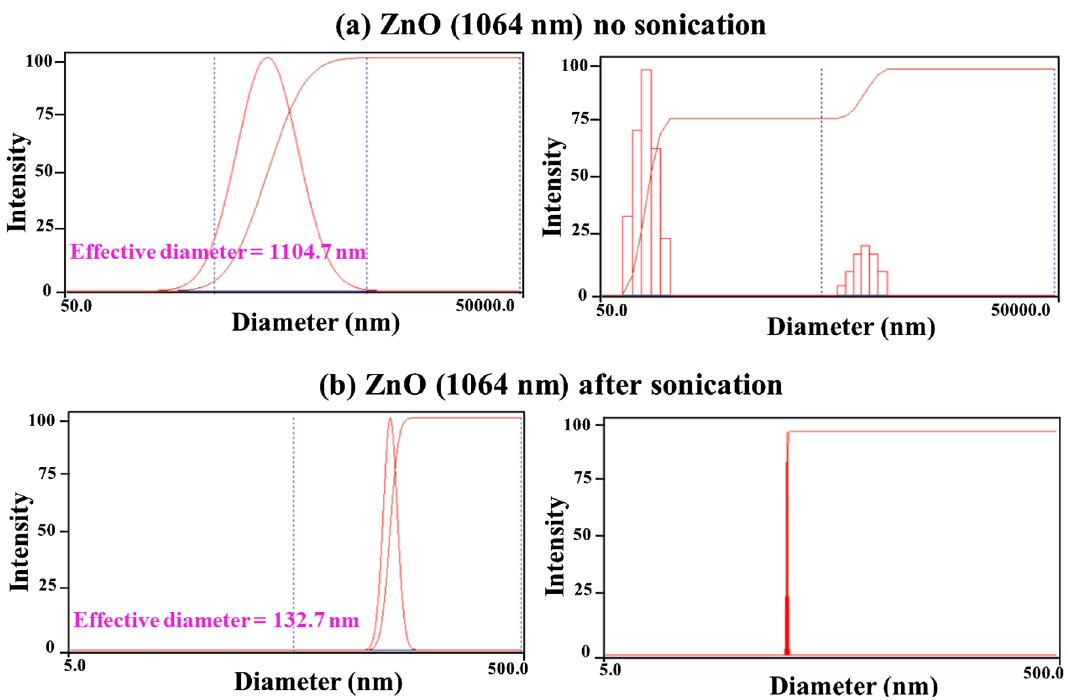
Figure 5. Results of the particle size distribution measurements after being irradiated with laser (1064 nm) for the ZnO powder without and after sonication.